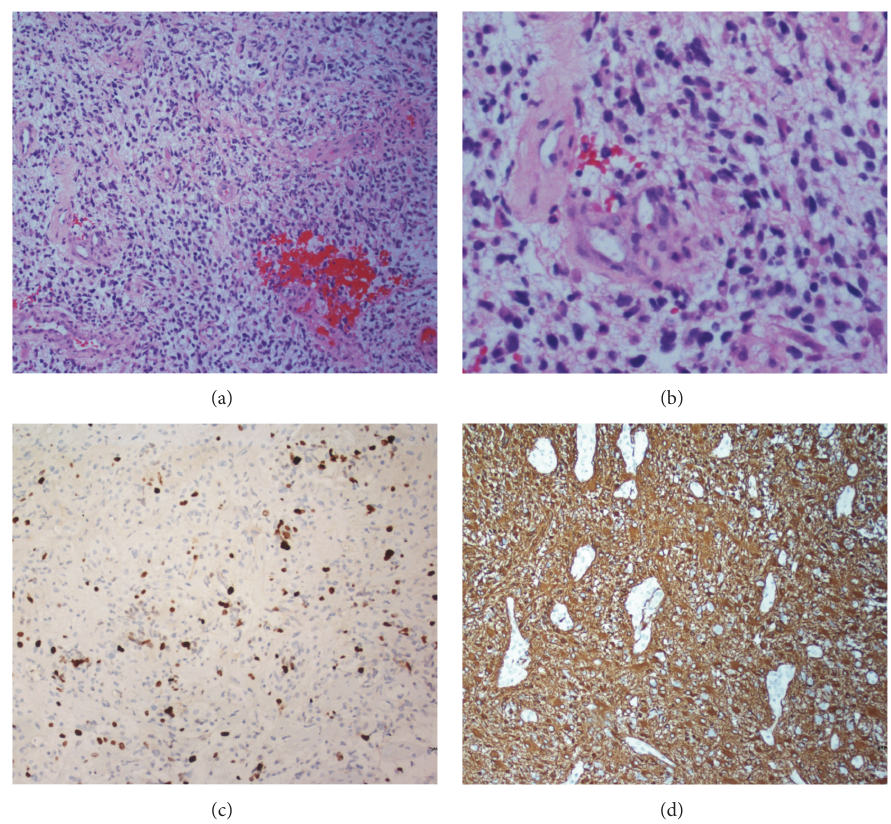
Figure 3: Microscopic image of the patient’s GBM. (a) Low-power micrograph of hemotoxylin and eosin staining, showing cellular atypia, glomeruloid vascular pattern, and areas of tumor necrosis diagnostic of GBM. (b) High-power micrograph showing atypical, hyperchromatic nuclei and numerous mitotic figures. (c) Low-power micrograph showing numerous cells staining positive for Ki67, a marker of cell proliferation. (d) Low-power micrograph showing staining for glial fibrillary acidic protein